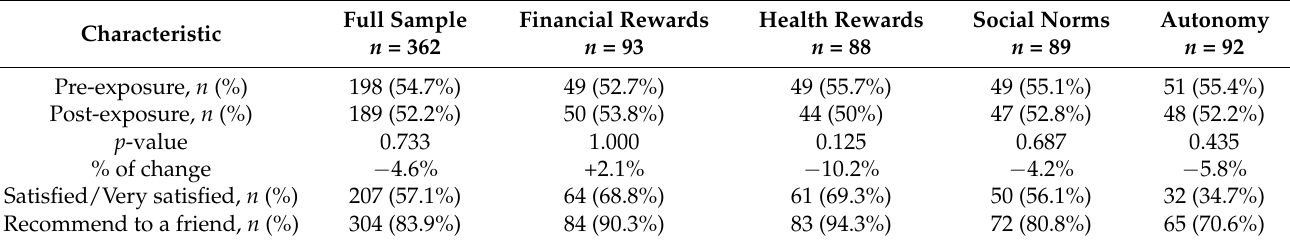
Table 2. Pre- and post-exposure on susceptibility to future